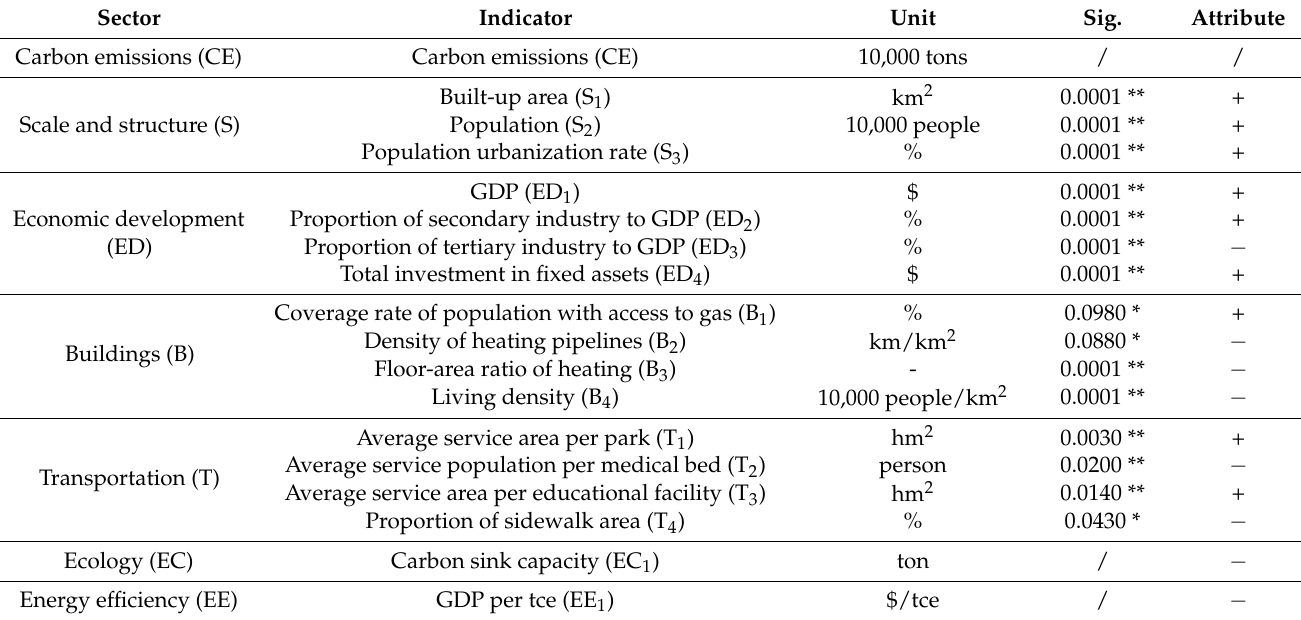
Table 2. Carbon emission governance indicator system for